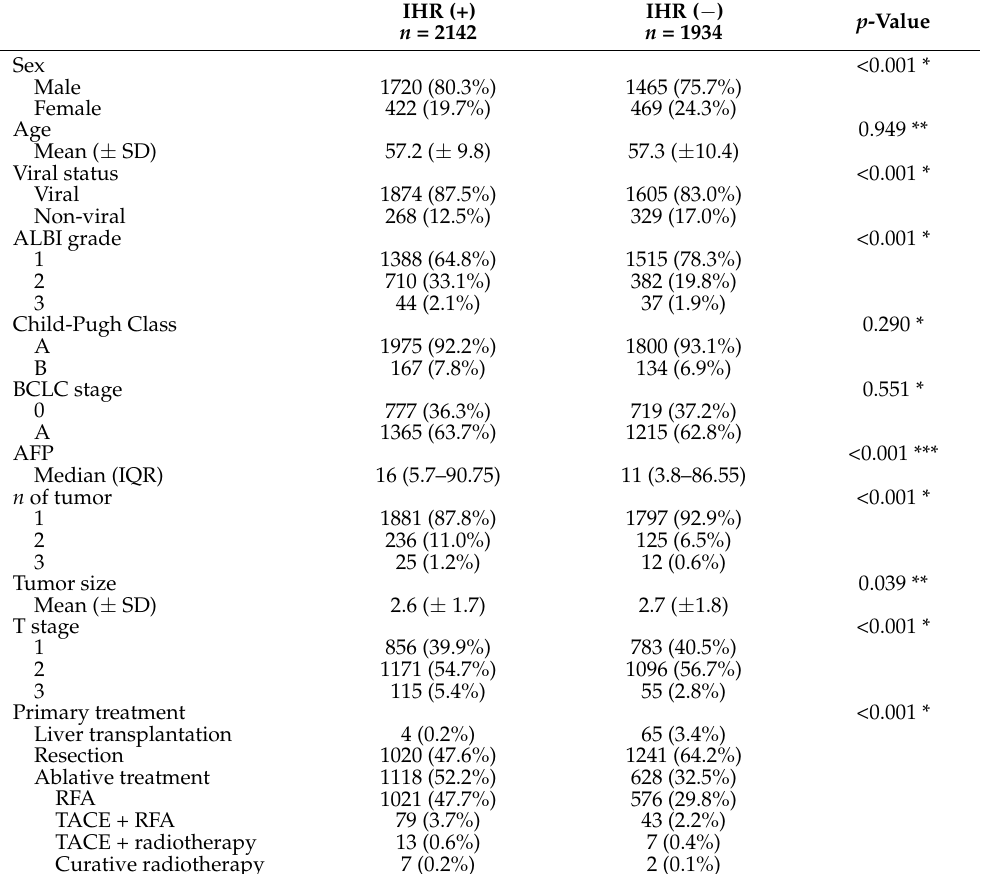
Figure 1. Flowchart of patient selection. HCC, hepatocellular carcinoma; BCLC, Barcelona Clinic Liver Cancer; IHR, intrahepatic recurrence. Table 1. Baseline clinical characteristics.